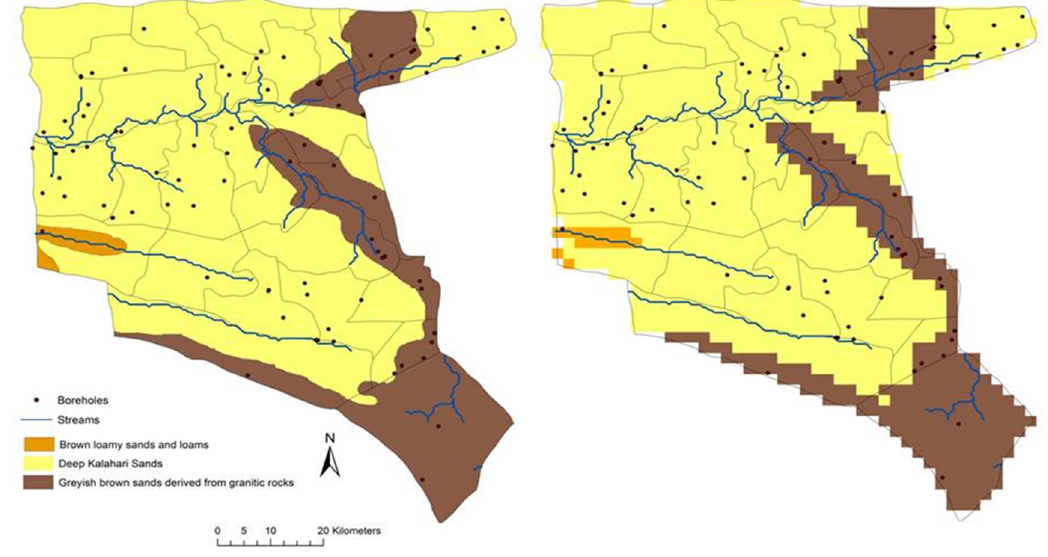
Figure 3. Nkayi soils map converted to 2 km resolution grid is used as inputs to the SAVANNA model.